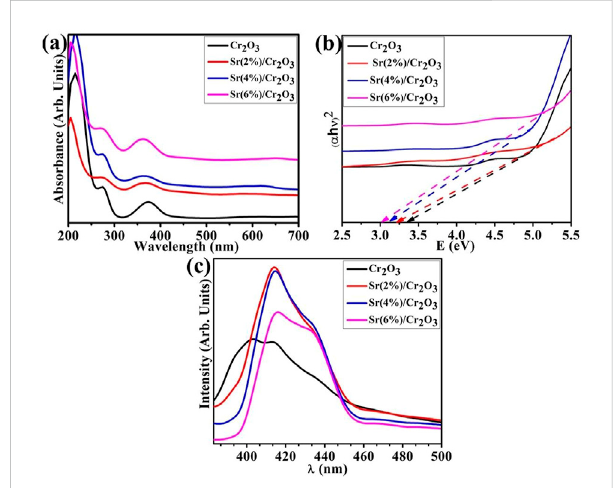
FIGURE 3 (A) opticalspectra, (B) bandgapenergydetermination,and (C) PL emission spectra of Cr 2 O 3 and Sr-doped Cr 2 O 3 .